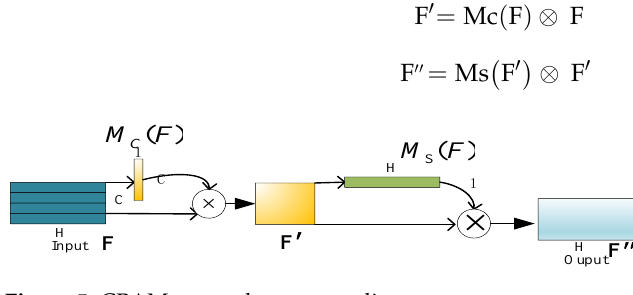
Figure 5. CBAM network structure diagram.